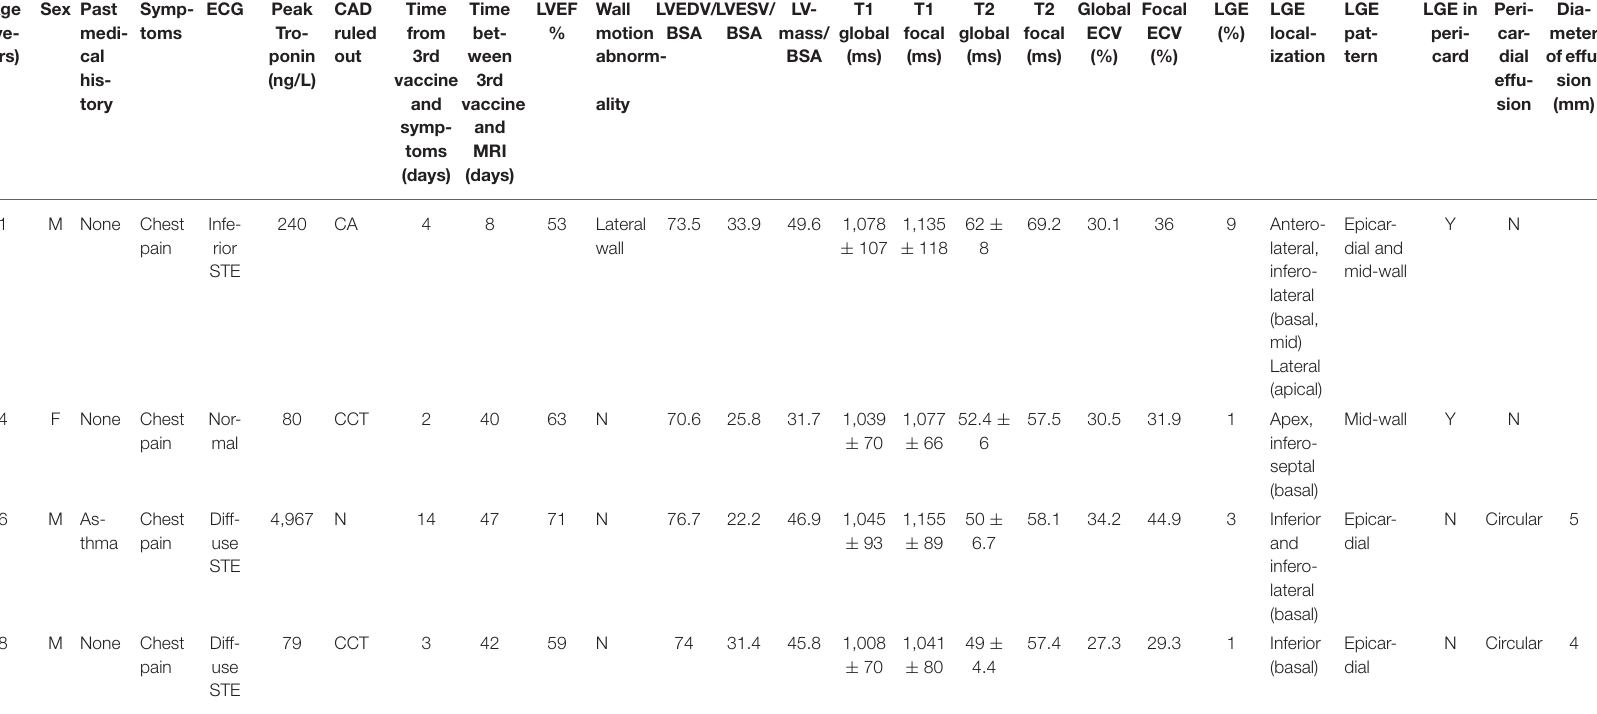
TABLE 1 | Clinical characteristics and CMR findings of the study patients. Age